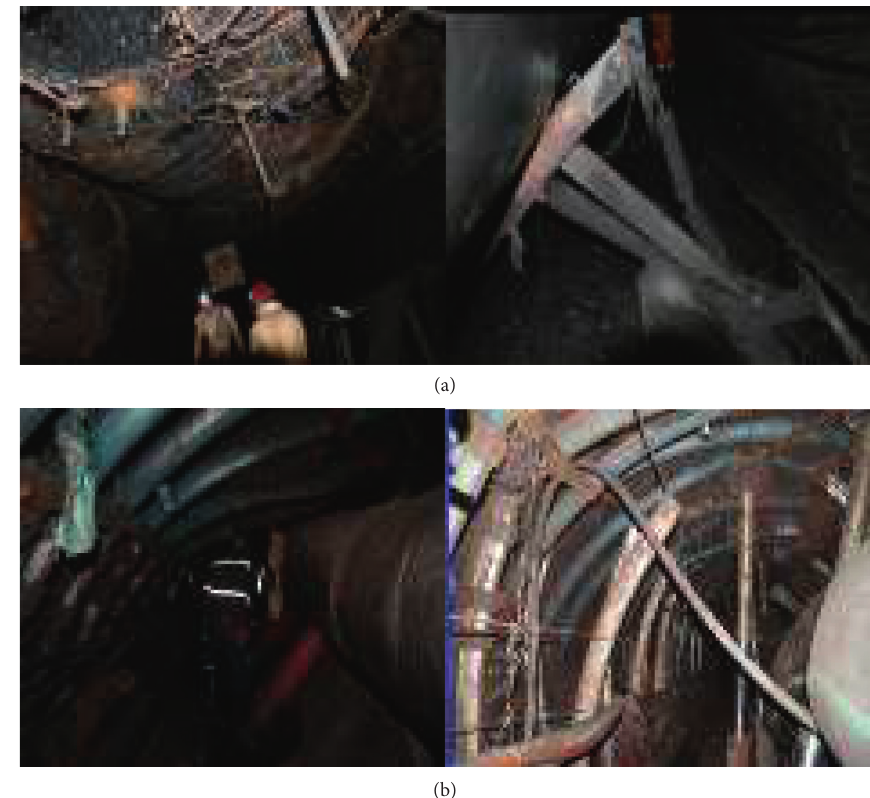
Figure 1: Typical mine earthquake disaster results caused by thick and hard rock strata movements. (a) Site image of a “2.28” mine earthquake disaster in the Gucheng Coal Mine of Shandong Province. (b) Site image of an “11.3” mine earthquake disaster in the Qianqiu coal mine of Henan Province.